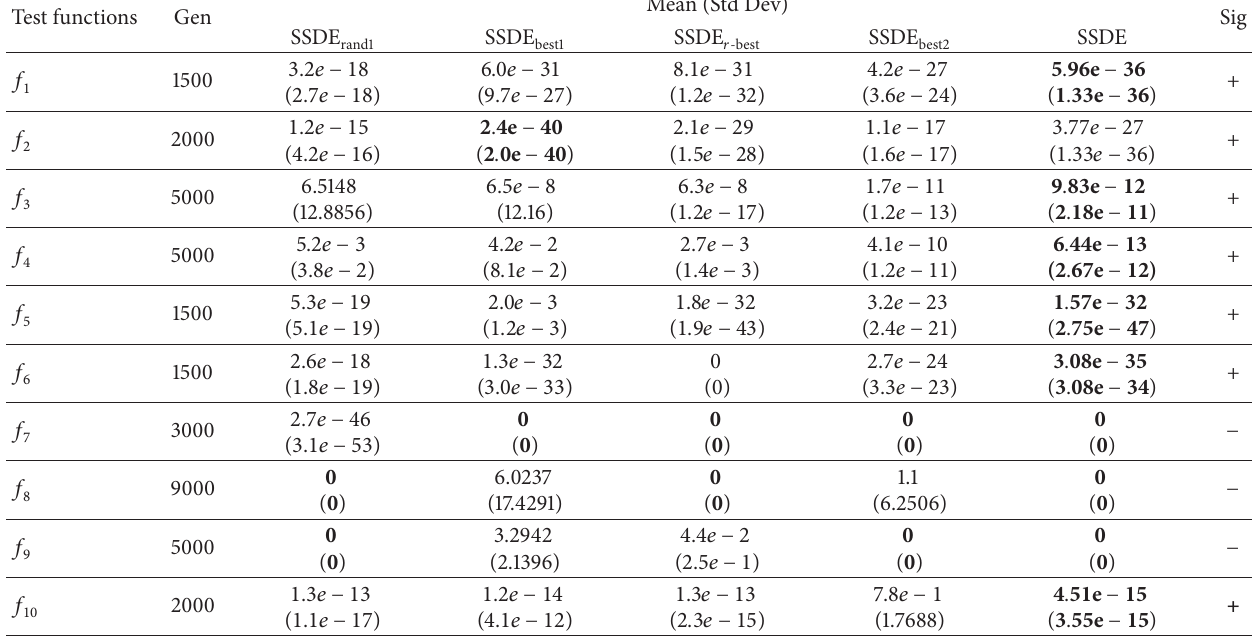
Table 2: Comparison results between SSDE algorithms with and without adaptive selection method.